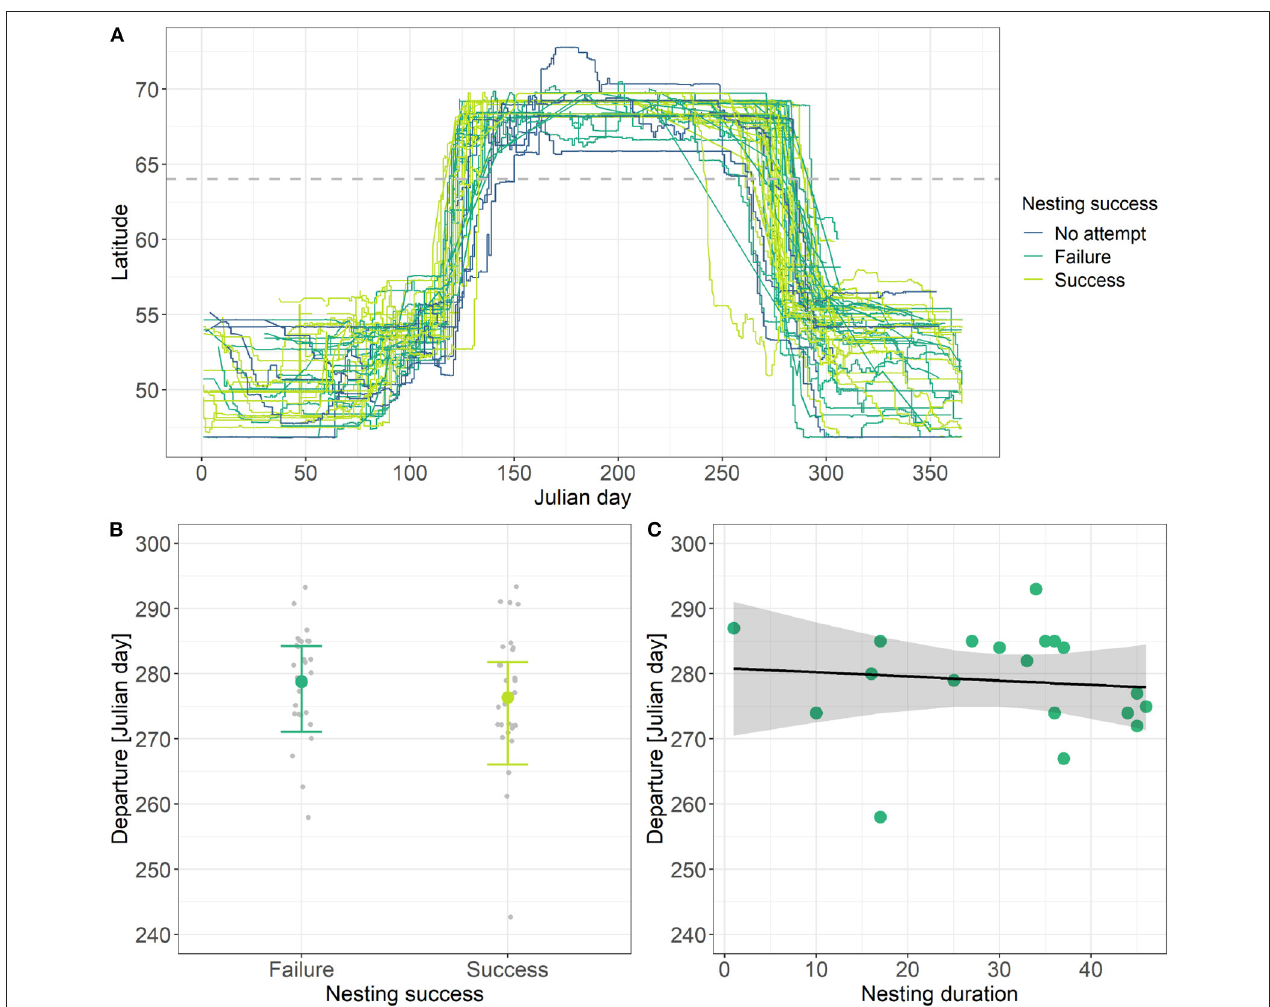
FIGURE 3 | Relationship between the nesting success and departure days in rough-legged buzzards. (A) Latitude change during the annual life-cycle. (B) Departure day as a response of nesting success (predicted 95% CIs from LMM using the bootstrapping method and 500 simulations in “ciTools” R package ( Haman and Avery, 2020 ) with lower limit representing minimum CI and upper limit representing maximum CI; gray dots represent raw data). (C) Departure day as a response of nesting duration of individuals that failed to breed (predicted CIs from LM with only 1 year of data per individual included; blue dots represent raw